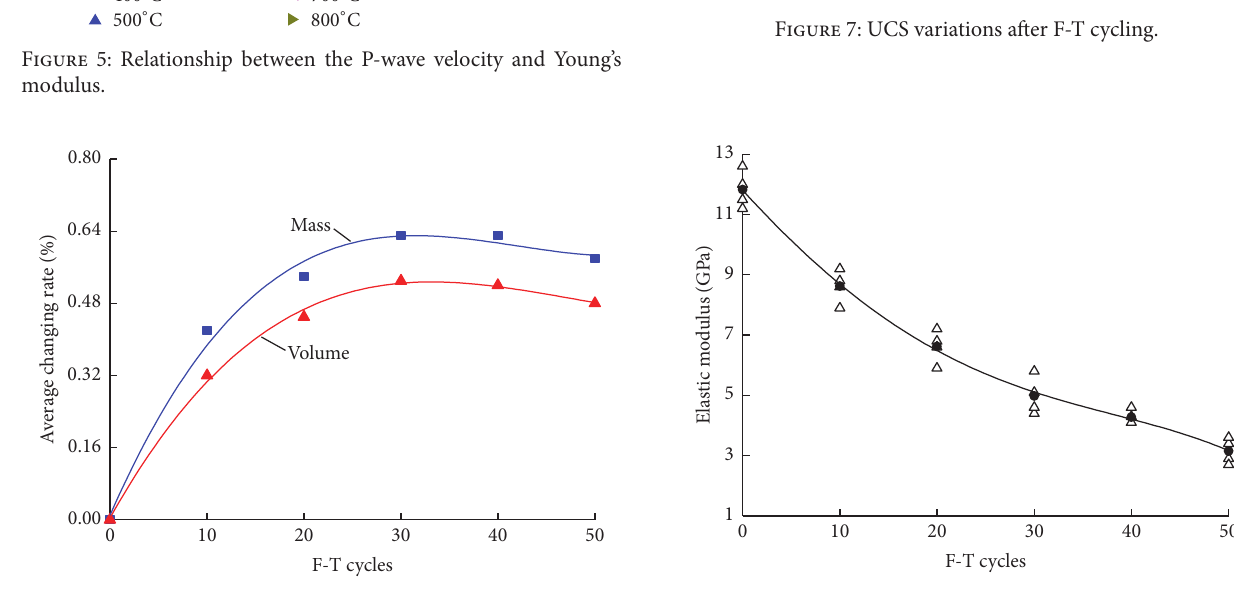
Figure 6: Effects of F-T cycling on the mass and volume of the sandstone specimens.